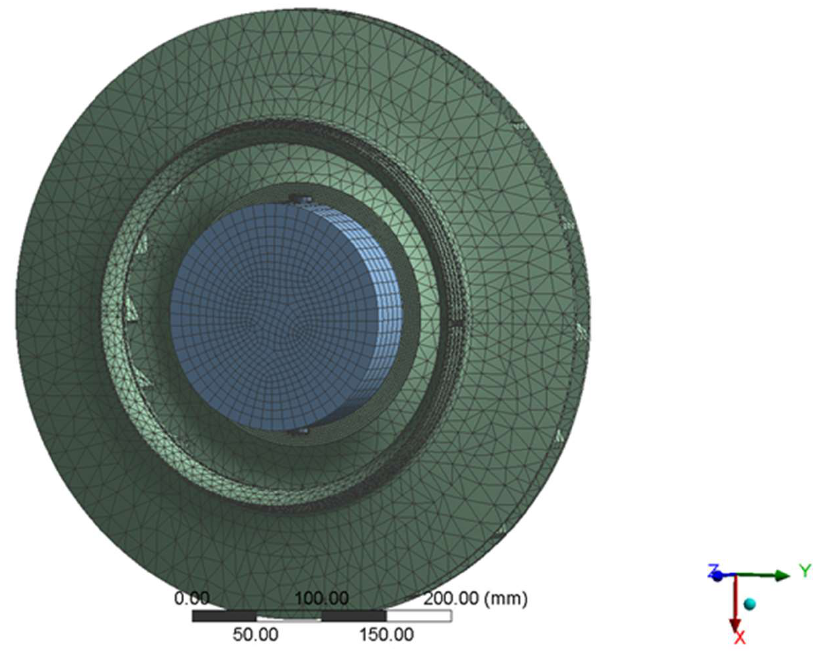
Figure 5. Mesh of the impeller model with a shaft